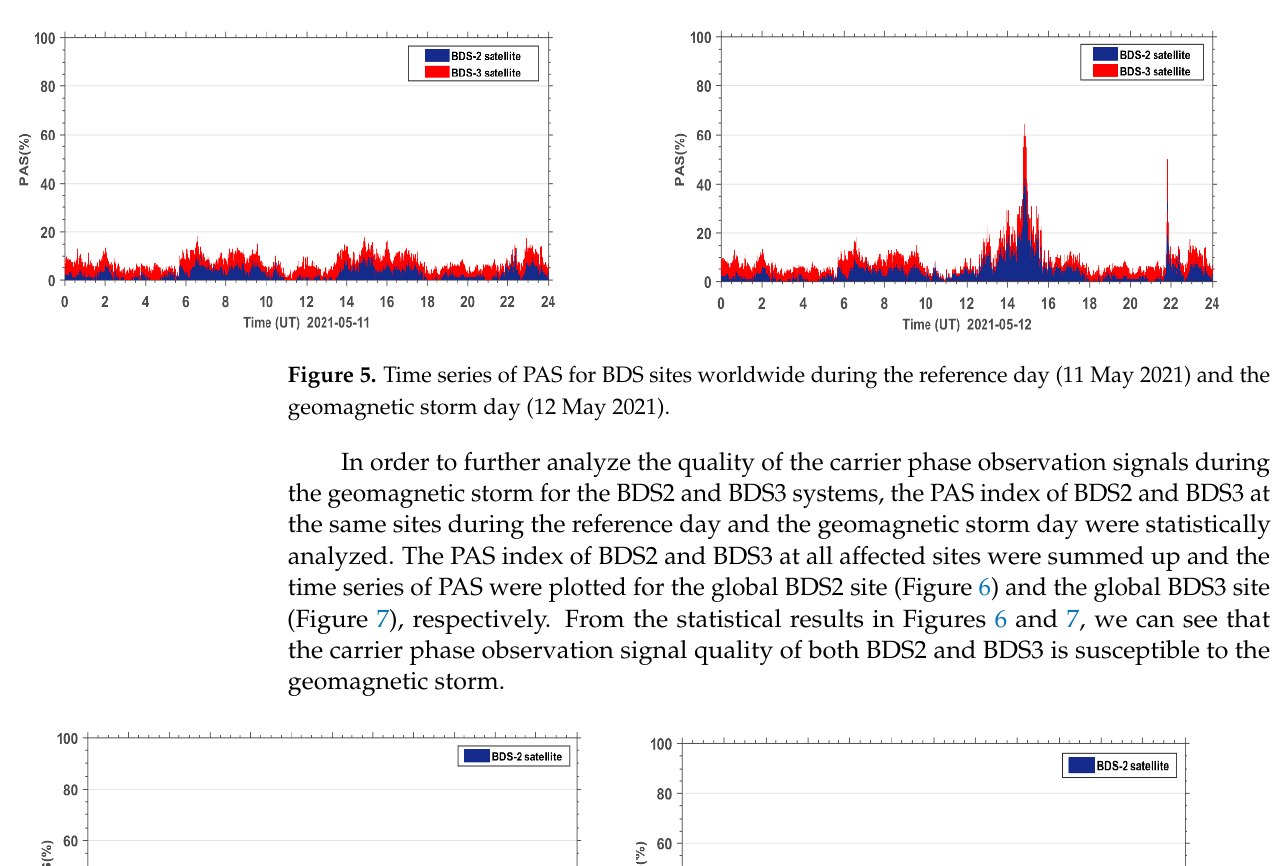
Figure 7. Time series of PAS for BDS3 sites worldwide during the reference day (11 May 2021) and the geomagnetic storm day (12 May 2021). The new PAS index is the sum of three indices, that is P SLGS , P LLI , and P GF . To demon- strate why the three indices should be added together to form a new index, we present the individual result of P SLGS , P LLI , and P GF during the reference day and the geomagnetic storm day in Figure 8. The results show that all three indices contribute to the PAS during geomagnetic storms. The P GF contributes the most to the PAS, followed by the P SLGS . In the case of existence of lost satellite signals, only the P SLGS index can be utilized to indicate the geomagnetic storms. The P LLI and P GF indices, same as ROTI, would fail. When the satellite signal is not lost, the P LLI index indicates the percentage of anomaly satellite signals caused by receiver performance due to geomagnetic storms, while the P GF index indicates the percentage of anomaly satellite signals suffering TEC fluctuation due to geomagnetic